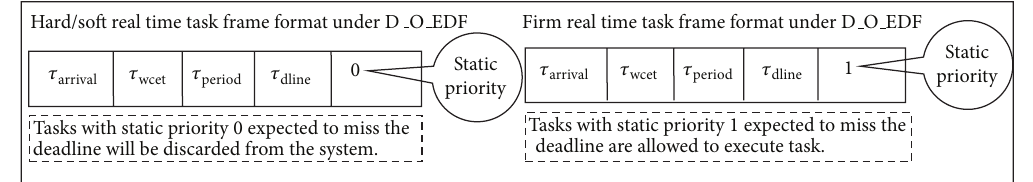
Figure 6: Real time tasks frame format according to D O EDF scheduling algorithm.